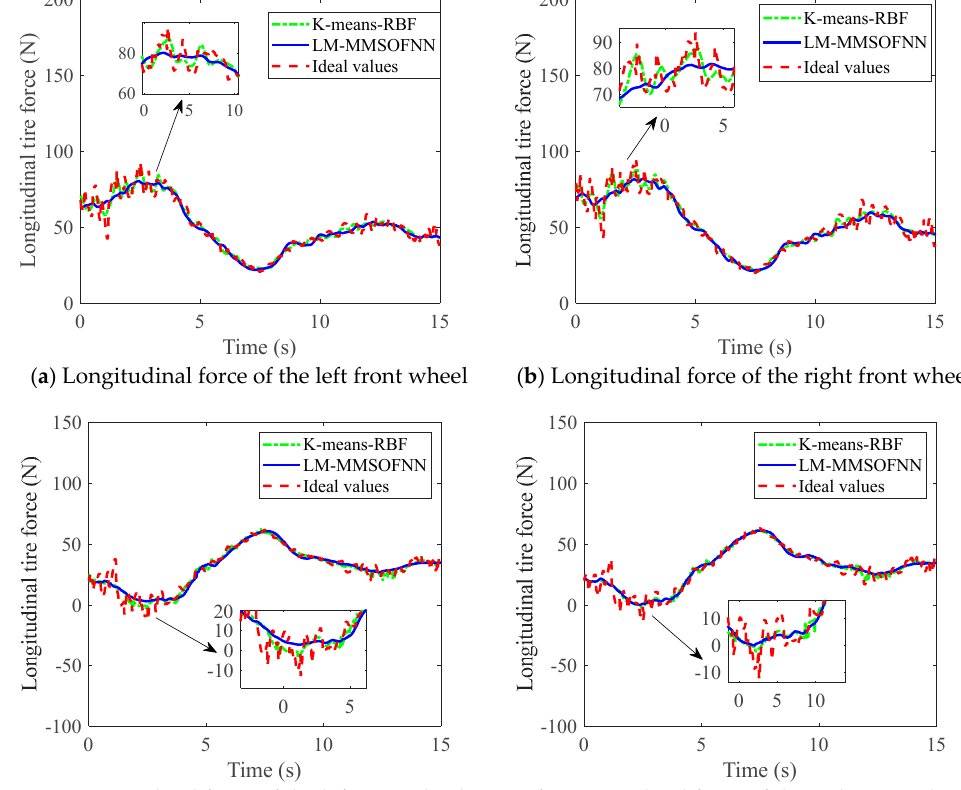
( c ) Longitudinal force of the left rear wheel ( d ) Longitudinal force of the right rear wheel